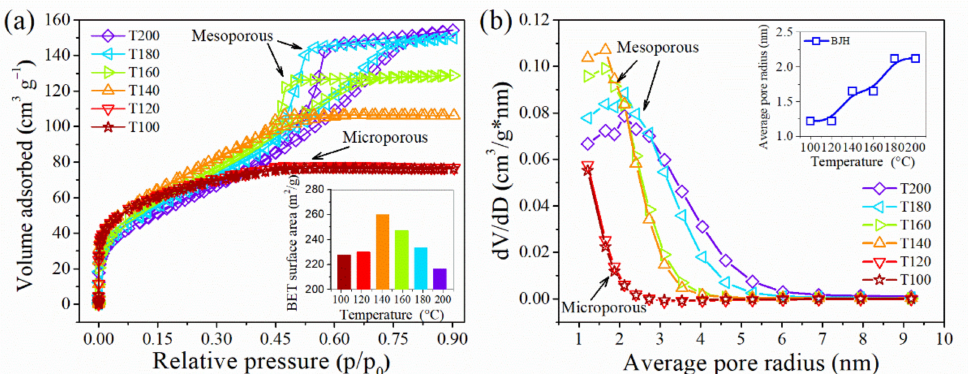
Figure 4. ( a ) Brunauer-Emmett–Teller (BET) N 2 adsorption–desorption curves for TiO 2 NP photocat- alyst samples (inset: BET surface area of samples synthesized at different temperatures) and ( b ) pore size distributions obtained by the BJH (Barrett, Joyner, Halenda) method (inset: Average pore radius of samples synthesized at different